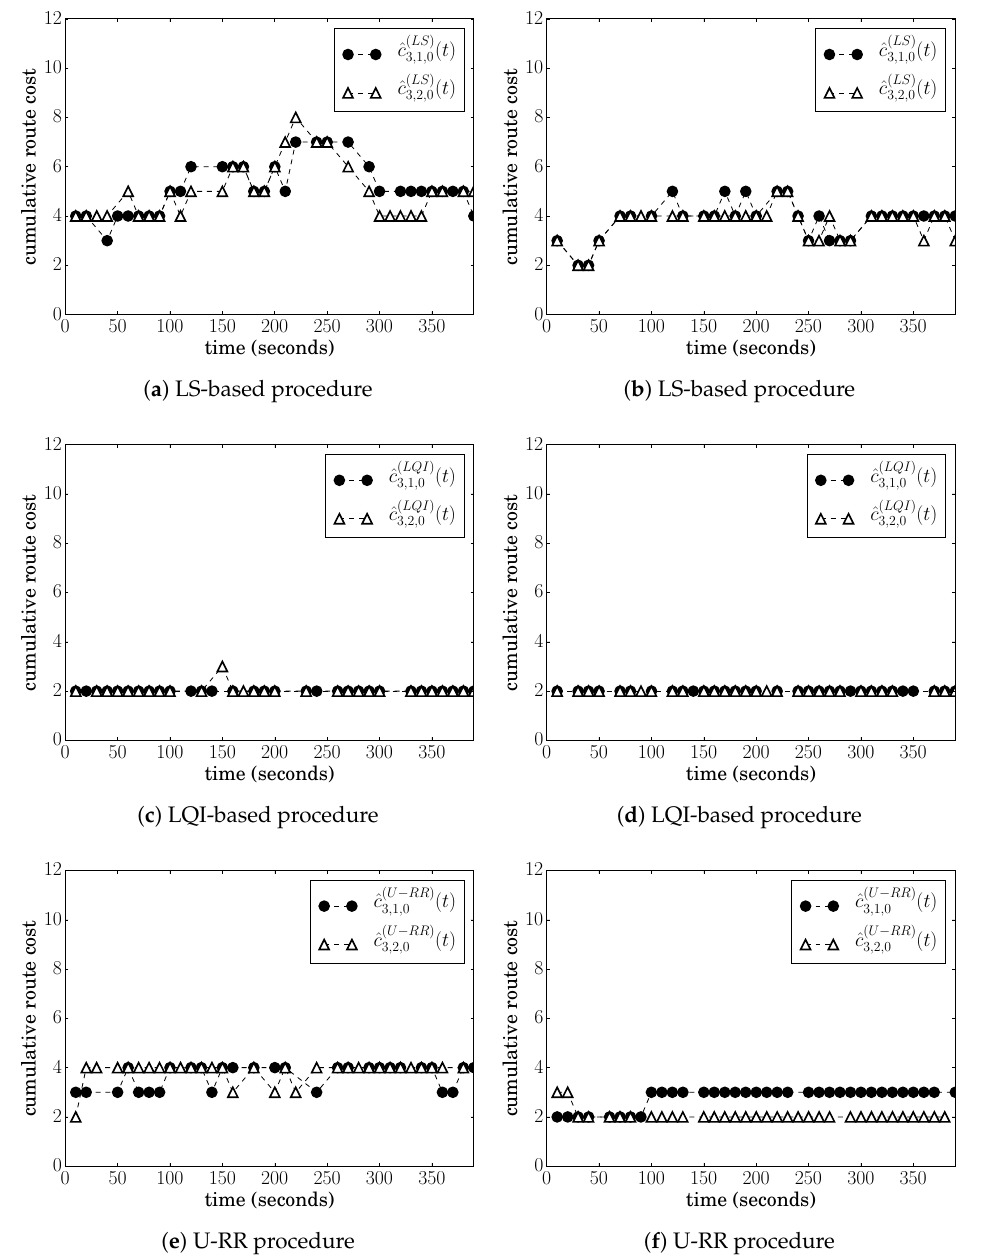
Figure 2. Cumulative route costs using the LS-based procedure, the LQI-based procedure, and the U-RR procedure (defined in Section 6) in topology of Figure 1. Results in ( a , c , e ) correspond to Example 1 in Section 5.1. Results in ( b , d , f ) correspond to Example 2 in Section